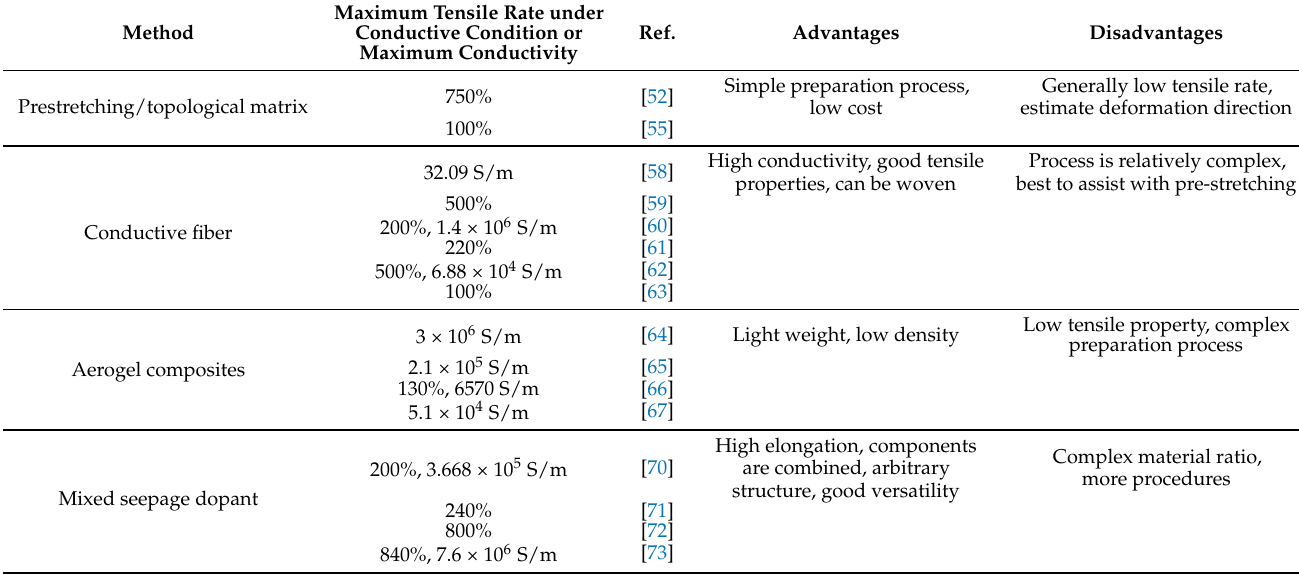
Figure 5. Preparation of Ag-Au nanocomposites. ( a ) Ag-Au nanocomposites are composed of a mixture of Ag-Au nanowires modified with hexamine ligands, SBS elastomers and another hexamine in toluene. ( b ) Diagram of solvent-drying process under environmental conditions. ( c ) The initial solution ( left ) is separated into an Ag-Au-rich nanowire phase and an SBS-rich phase ( middle ) during dry casting. The micro-structured Ag-Au nanowire nanocomposites are formed by solvent evaporation ( right ). Reprinted with permission from [73]. Copyright 2018 Springer Nature. A comparison of different preparation methods is shown in Table 1: Table 1. Comparison of different preparation